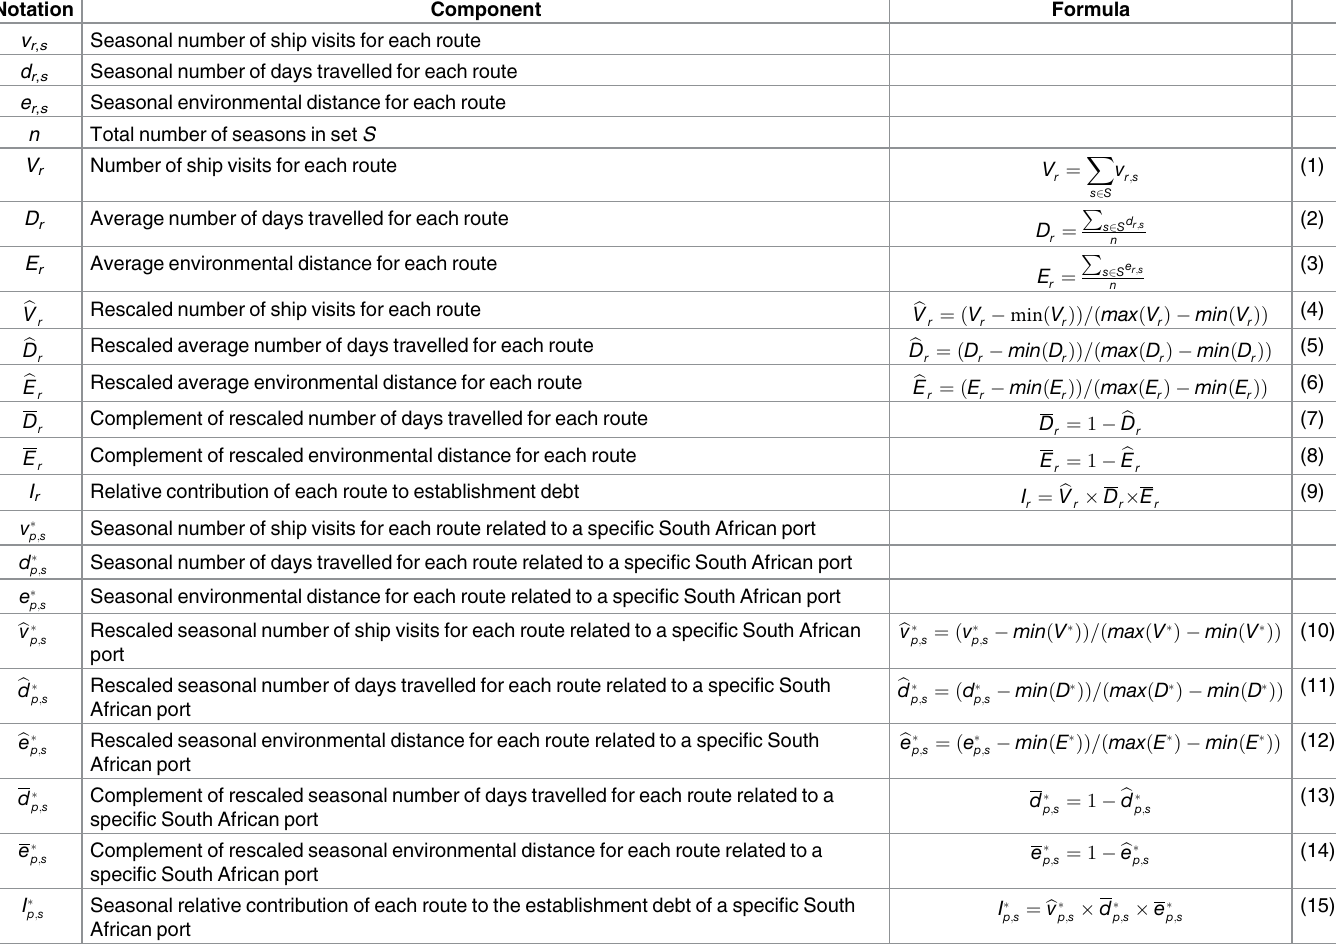
Table 1. The components considered when calculating the relative contribution of the shipping routes to establishment debt, the notation used to refer to each component and, where applicable, the formulae used to calculate the